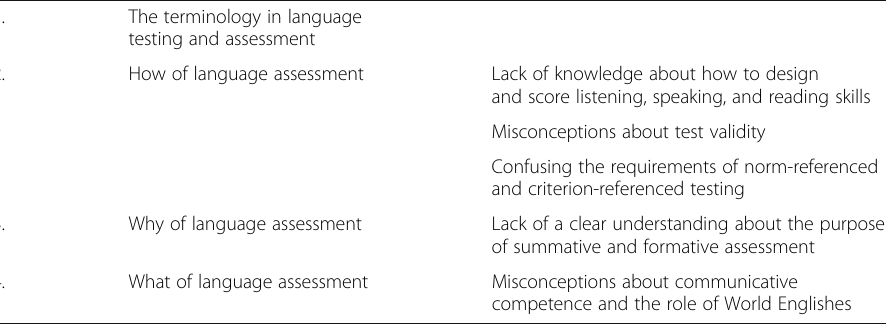
Table 2 Major areas of assessment